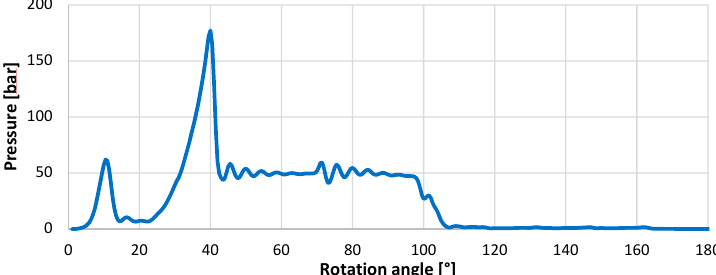
Figure 10. Instantaneous displacement chamber pressure curve for half a revolution at 50-bar delivery pressure and 4000 rpm.